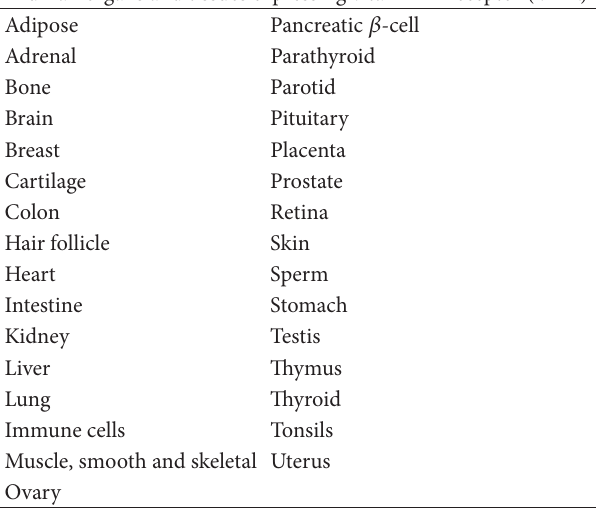
Table 1: VDR is almost ubiquitary expressed in humans. Many of human tissues and organs express VDR: upon ligand-receptor inter- action genomic and nongenomic action likely occur by endocrine, paracrine, and autocrine